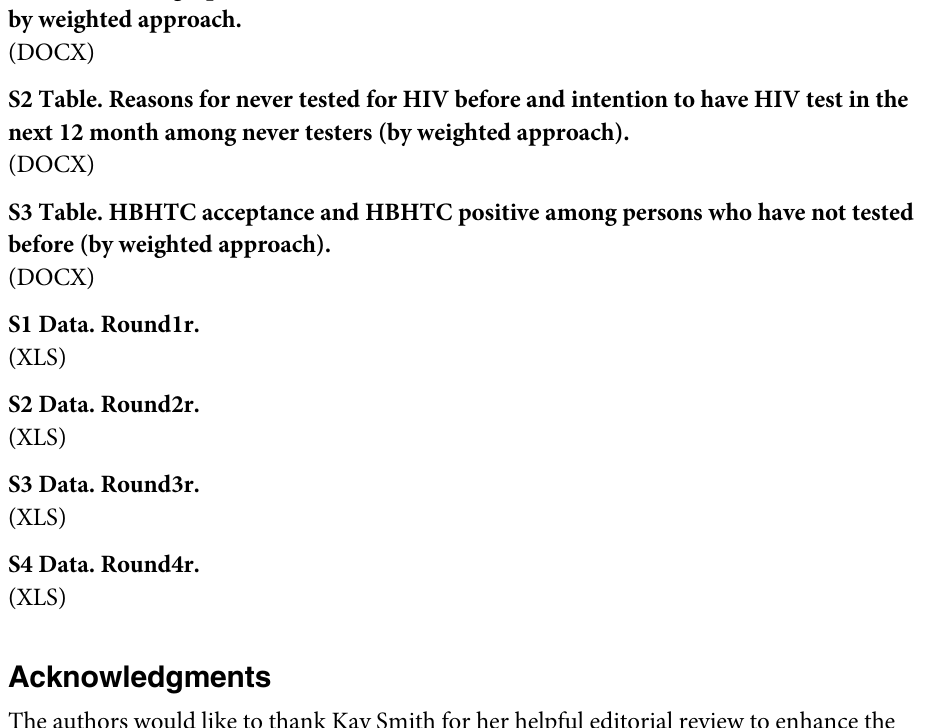
S1 Table. Demographic and behavioral factors associated with never tested for HIV before by weighted approach. S2 Table. Reasons for never tested for HIV before and intention to have HIV test in the next 12 month among never testers (by weighted approach). S3 Table. HBHTC acceptance and HBHTC positive among persons who have not tested before (by weighted